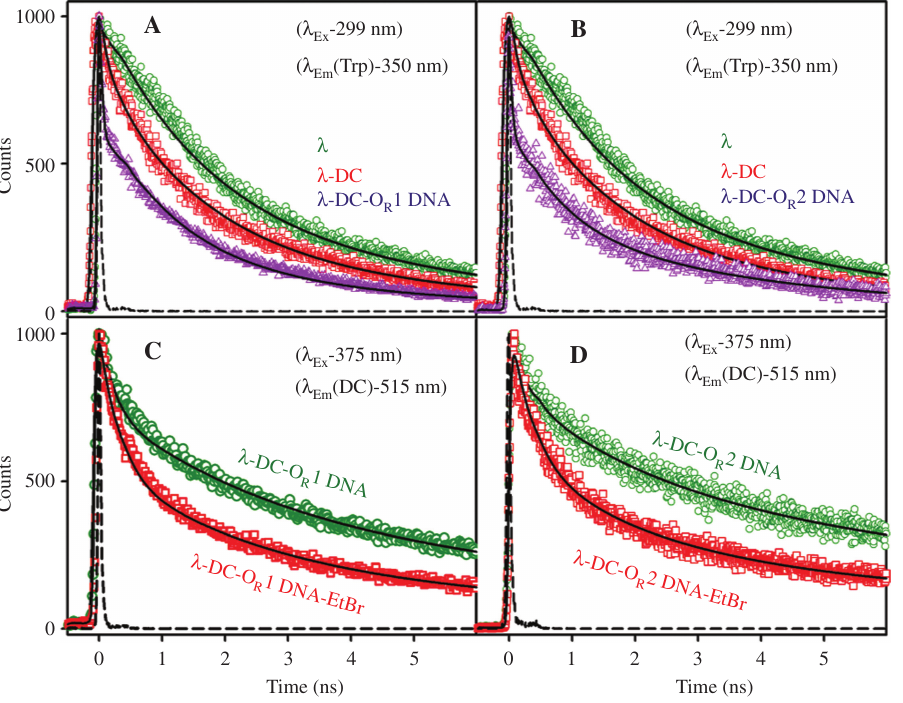
Figure 11 FRET studies in operator-repressor